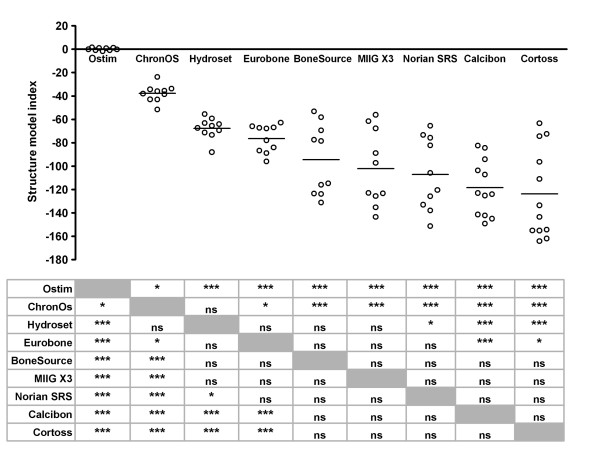
Structure model index of bone substitutes The structure model index of individual test samples was determined upon Micro-CT-scanning as described in the Materials and Methods. Each dot represents an individual test sample, and lines indicate the average value. The table below the figure shows the outcome of the pairwise comparisons (Student's T-test with Bonferroni correction). *, p < 0.05; **, p < 0.01; ***, p < 0.005; ns, not statistically significantly different. Grey boxes represent the self-self combinations, which could not be tested.